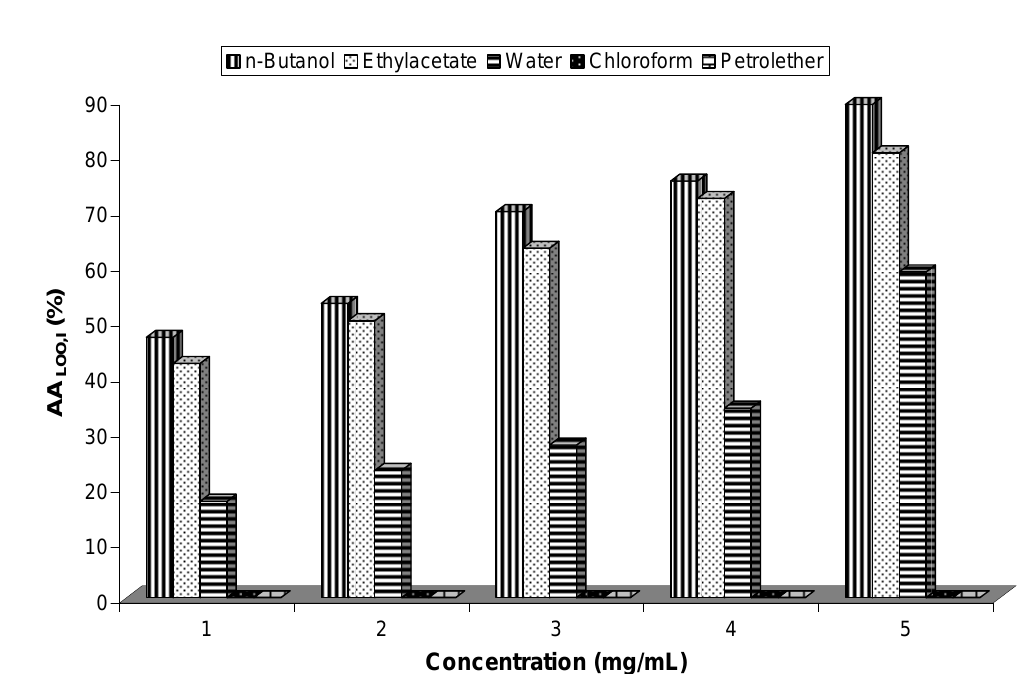
Figure 4. Antioxidant activity of different concentrations of n -butanol, ethyl acetate, water, chloroform and petroleum ether extracts of Satureja montana L. subsp . kitaibelii on PBN-OOL spin adduct during ACVA-induced peroxidation of sunflower oil (Data are represented as inhibition percentage of PBN- OOL spin adduct peak height measured by